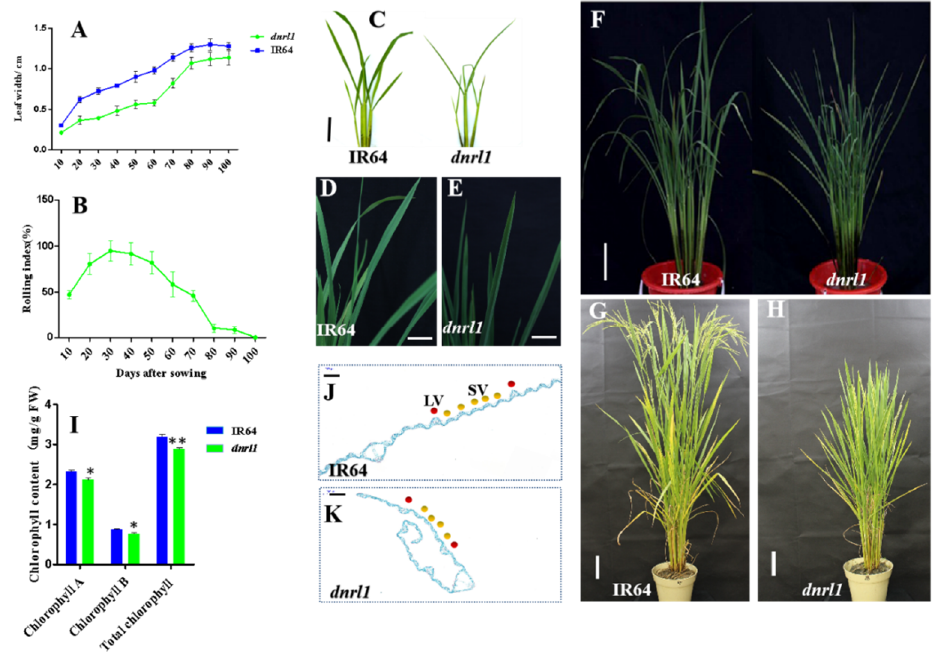
Figure 1. Performance of dnrl1 under field conditions. ( A ) Leaf width of IR64 and dnrl1, the abscissa represents days after sowing; ( B ) dynamic leaf rolling index of dnrl1 ; (C-H) phenotype of IR64 and dnrl1 at 4 weeks old (( C ); bar = 2 cm) and 9 weeks old ( D – F ); ( D ) and ( E ), upper leaf blades of IR64 and dnrl1 (for ( D ) and ( E ), bar = 2 cm; for ( F ), bar = 5 cm); 14-week-old plants of IR64 and dnrl1 (( G ) and ( H ), bar = 10 cm); ( I ) chlorophyll contents of IR64 and dnrl1 at 20 days after sowing (DAS). Values are means ± standard deviation (SD) ( n = 3), * indicates significance at p ≤ 0.05, ** indicates significance at p ≤ 0.01 by Student’s t test.; ( J ) and ( K ), cross-section of IR64 and dnrl1 (for ( J ) and ( K ), bar = 200 µ m), red dot indicates large vein (LV), yellow dot indicates small vein (SV).